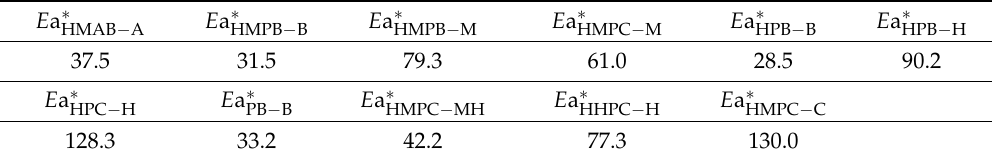
Table 3. Activation energies of heterogeneous reactions (kJ mol − 1